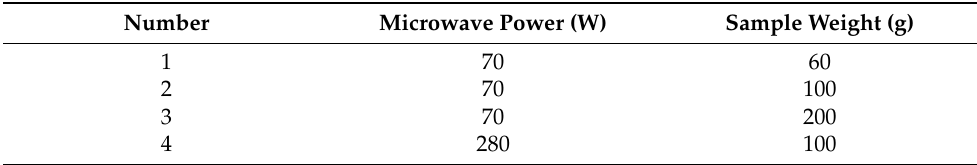
Table 1. Experimental scheme of microwave